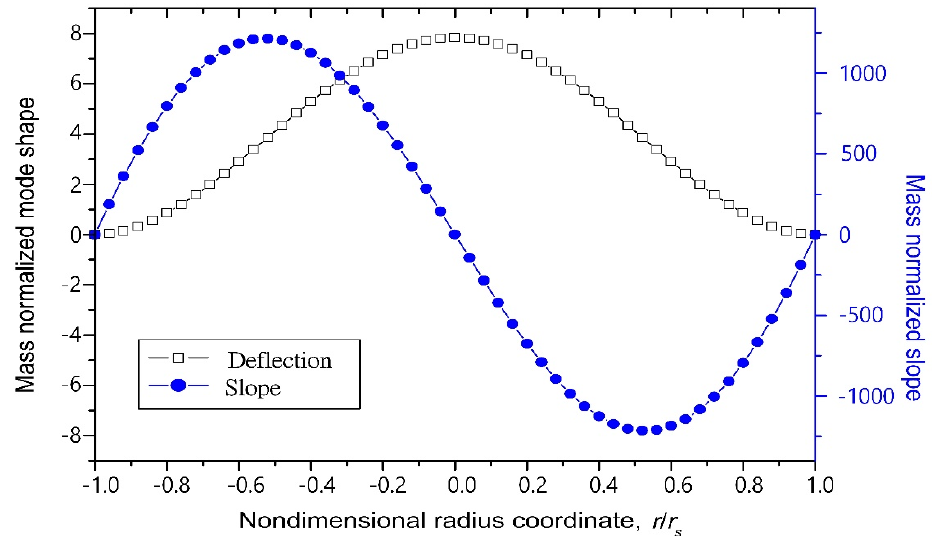
Figure 6. The mass-normalized mode shape and slope of clamped-edge disk.